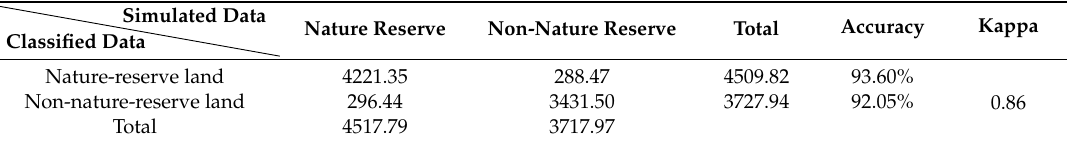
Table 7. Kappa coe ffi cient test table of nature reserve land in 2013 (unit: km 2 ).